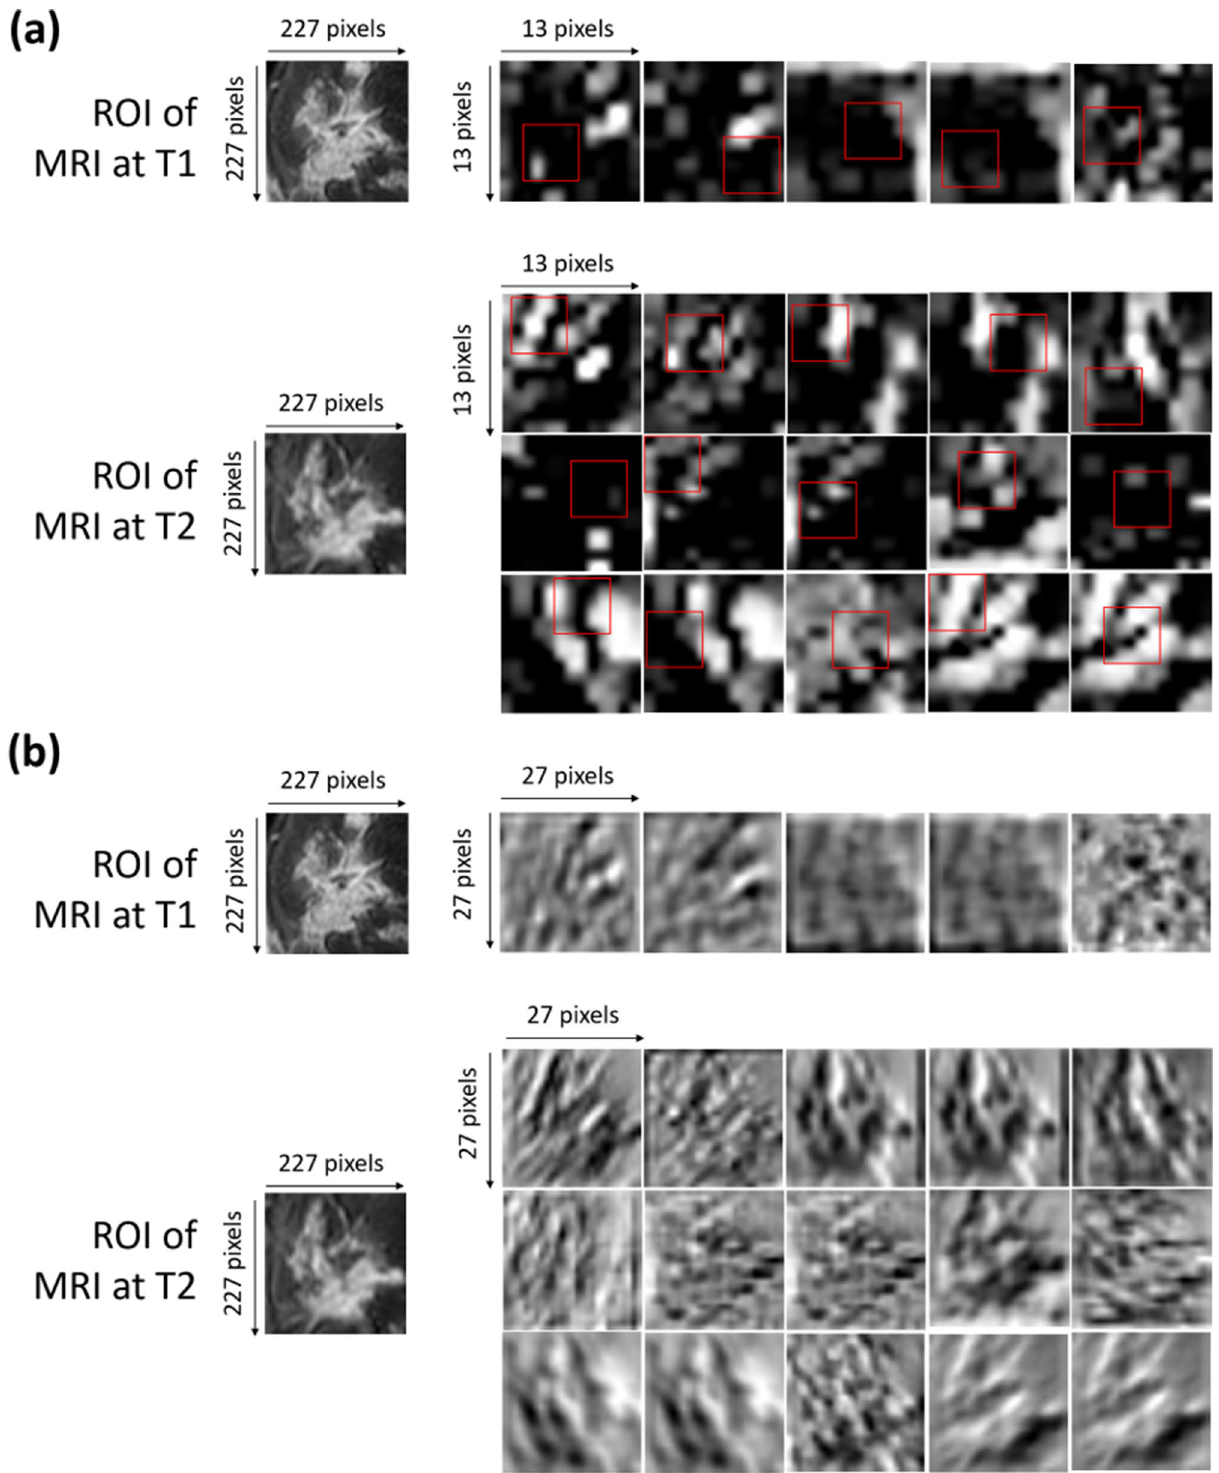
Figure 3. ( a ) Activation maps of the ROIs of both MRI at T1 and MRI at T2 from which the selected optimal features were extracted. The red squares outline with more precision the area of belonging of such features. Each ROI has dimensions of 227 × 227 pixels. Each activation map has original dimensions of 13 × 13 pixels and has been resized to the dimensions of the corresponding ROIs for a better visualization. ( b ) Convolutional maps related to the activation maps of the ROIs of both MRI at T1 and MRI at T2 from which the selected optimal features were extracted. Each ROI has dimensions of 227 × 227 pixels. Each convolutional map has original dimensions of 27 × 27 pixels and has been resized to the dimensions of the corresponding ROI for a better